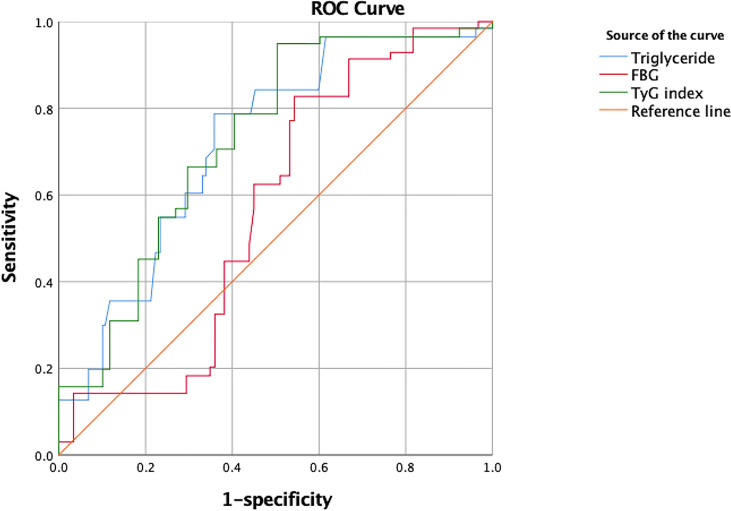
The ROC curve of triglyceride, FBG and TyG index for predicting CI-AKI.